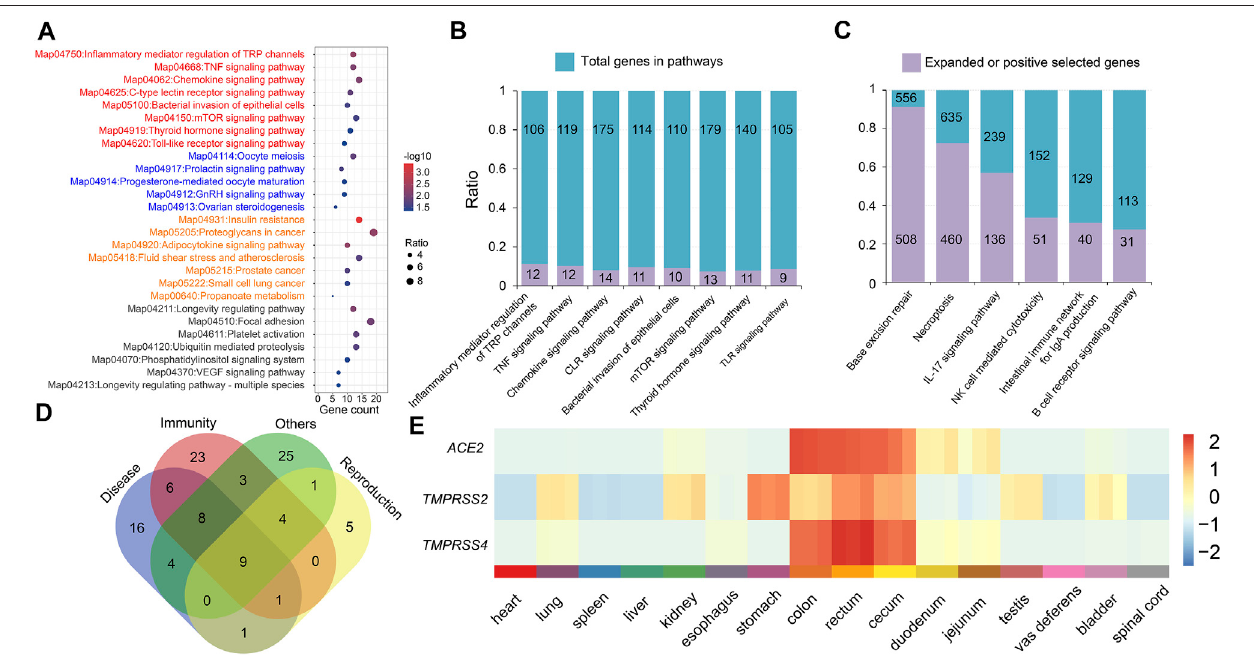
FIGURE 4 | Enriched KEGG pathways related to the immune system and the RNA expression pro fi le of ACE2 and TMPRSS2/TMPRSS4 genes. (A) Enriched KEGGpathwaysofthe622PSGsofthe P.larvata compared with19otherspecies.Red,pathwaysrelated toimmunity;blue,pathways relatedtoreproduction; orange, pathways related to disease. (B) The number of PSGs in the eight signi fi cantly enriched KEGG pathways related to the immunity. (C) The number of genes in the expandedgenefamiliesinthesixenrichedKEGGpathwaysrelatedtotheimmunity. (D) ThegenenumberofPSGsinsigni fi cantlyenrichedKEGGpathwaysrelated to immunity, reproduction, and disease. Some genes were shared in different pathways. (E) The expression heatmap of ACE2 , TMPRSS2 , and TMPRSS4 genes in 16 organs of the masked palm civet. Z-scores were calculated from TPM values for each of the three genes. Gene expression is colored from low (blue) to high (red).